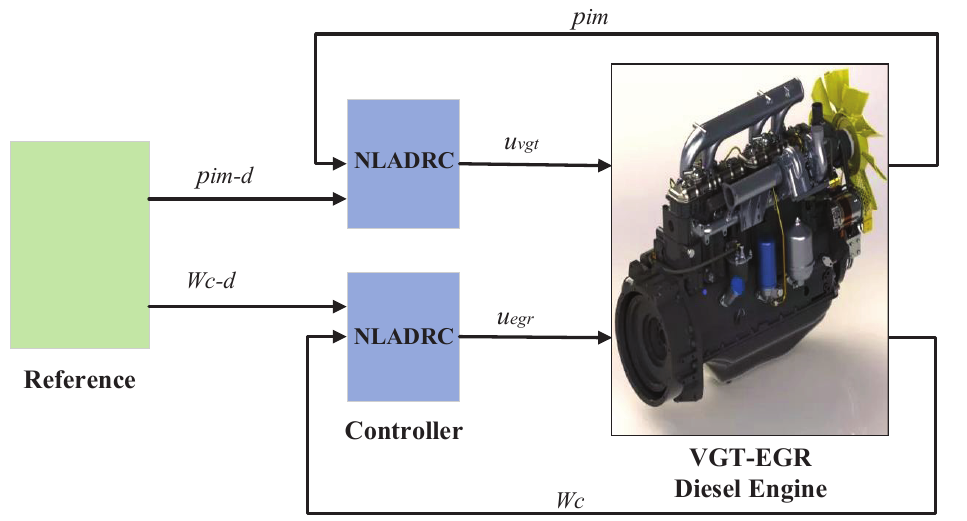
Figure 2. NLADRC controller diagram.